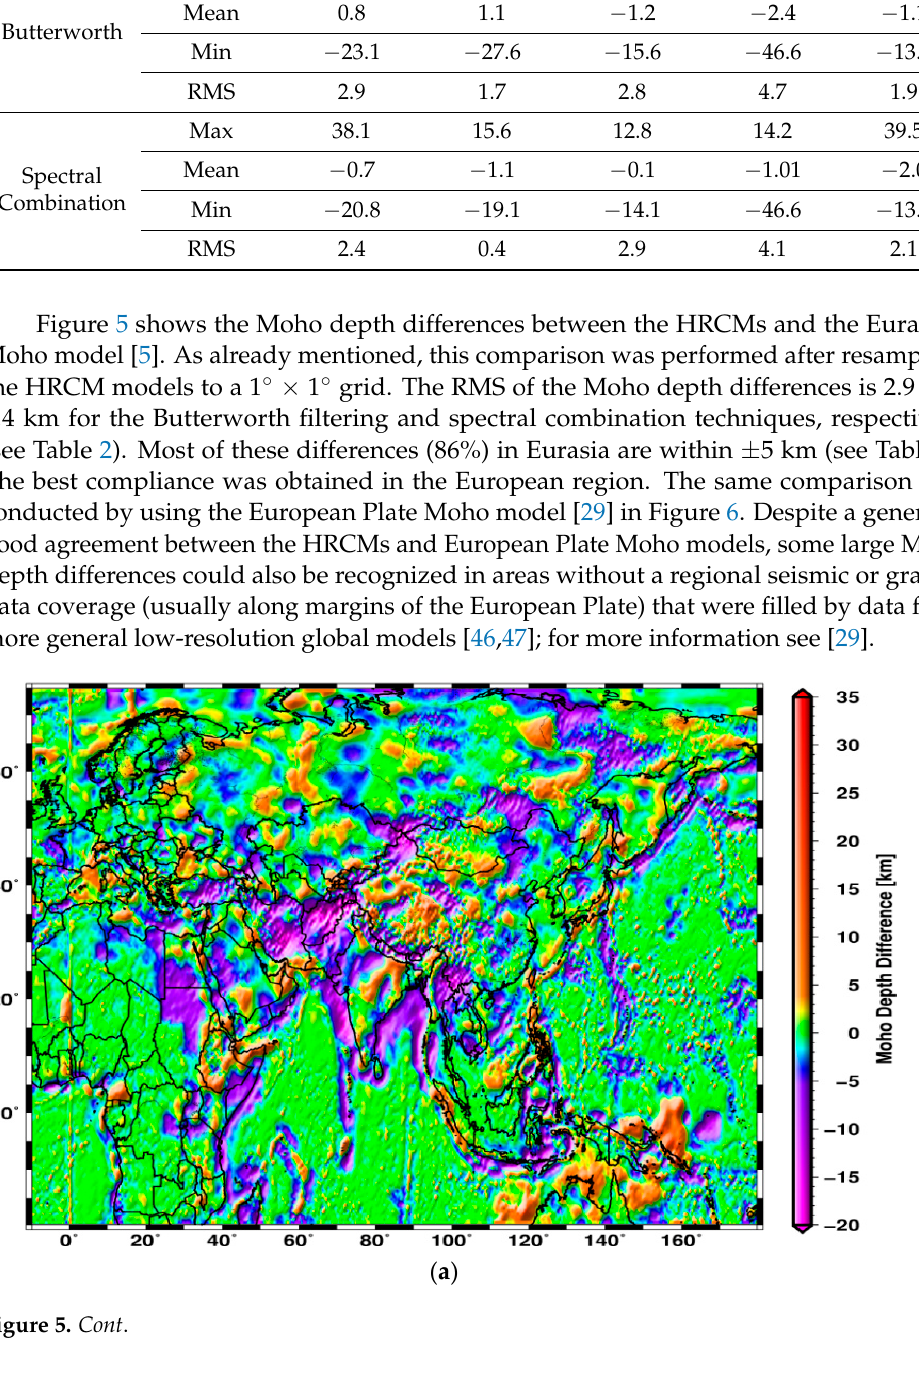
Table 3. Statistics of the HRCM Moho depth differences with respect to the continental and regional Moho models [5,29–32].